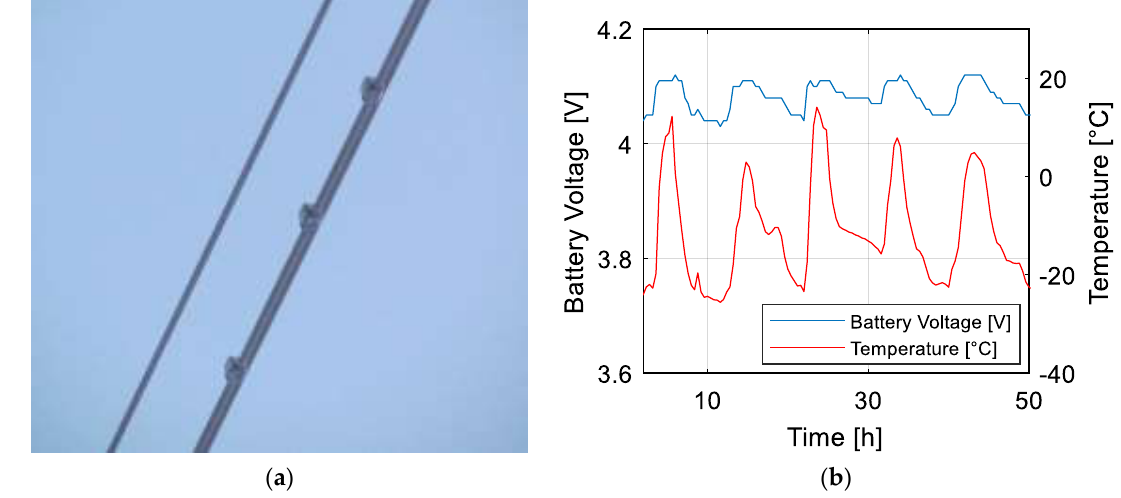
Figure 11. Manitoba field test: ( a ) WindNodes mounted on the lower conductor [1] © 2020 IEEE and ( b ) battery voltage trends with respect to environmental temperature.